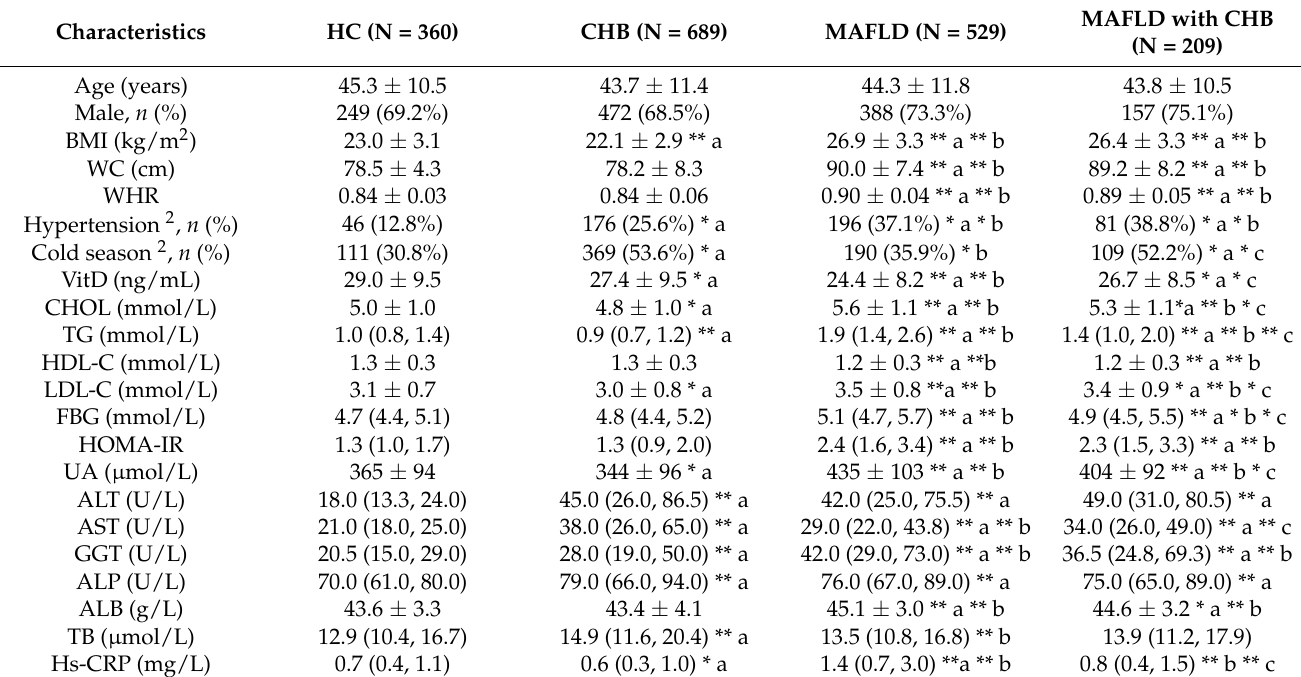
Table 1. Demographic and clinical characteristics of enrolled subjects 1 .